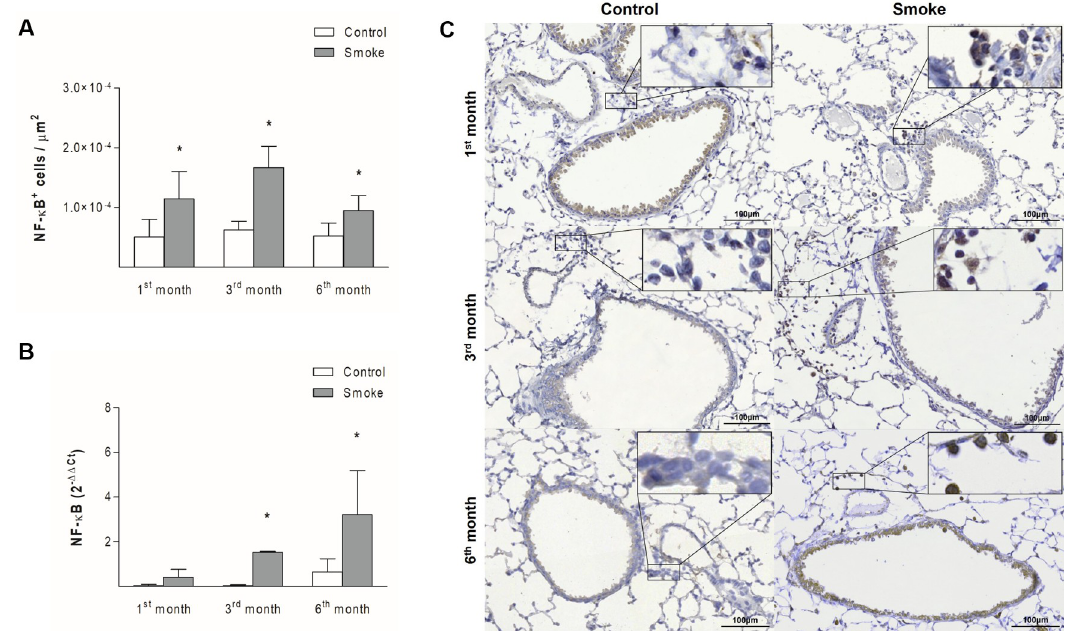
Fig 2. NF- κ B expression in peribronchovascular areas and bronchiolar epithelial cells. The numbers of NF- κ B + cells in peribronchovascular areas (A) and the NF- κ B gene expression levels in bronchiolar epithelial cells (B) obtained for the Control groups after 1 (n = 10 and 5, respectively), 3 (n = 6 and 5, respectively), and 6 (n = 7 and 4, respectively) months and the Smoke groups after 1 (n = 8 and 5, respectively), 3 (n = 5 and 4, respectively), and 6 (n = 10 and 4, respectively) months are presented as the means ± SDs. (A) Significant differences were found after 1 ( � P = 0.0025, t-test), 3 ( � P = 0.0001, t-test), and 6 ( � P = 0.0025, t-test) months. (B) Significant differences were found after 3 ( � P = 0.0001, Mann-Whitney test) and 6 ( � P = 0.0357, Mann-Whitney test) months. (C) Representative photomicrographs of NF- κ B + cells in peribronchovascular areas are shown at 200 × magnification, and images at 1000 × magnification are shown in each insert.